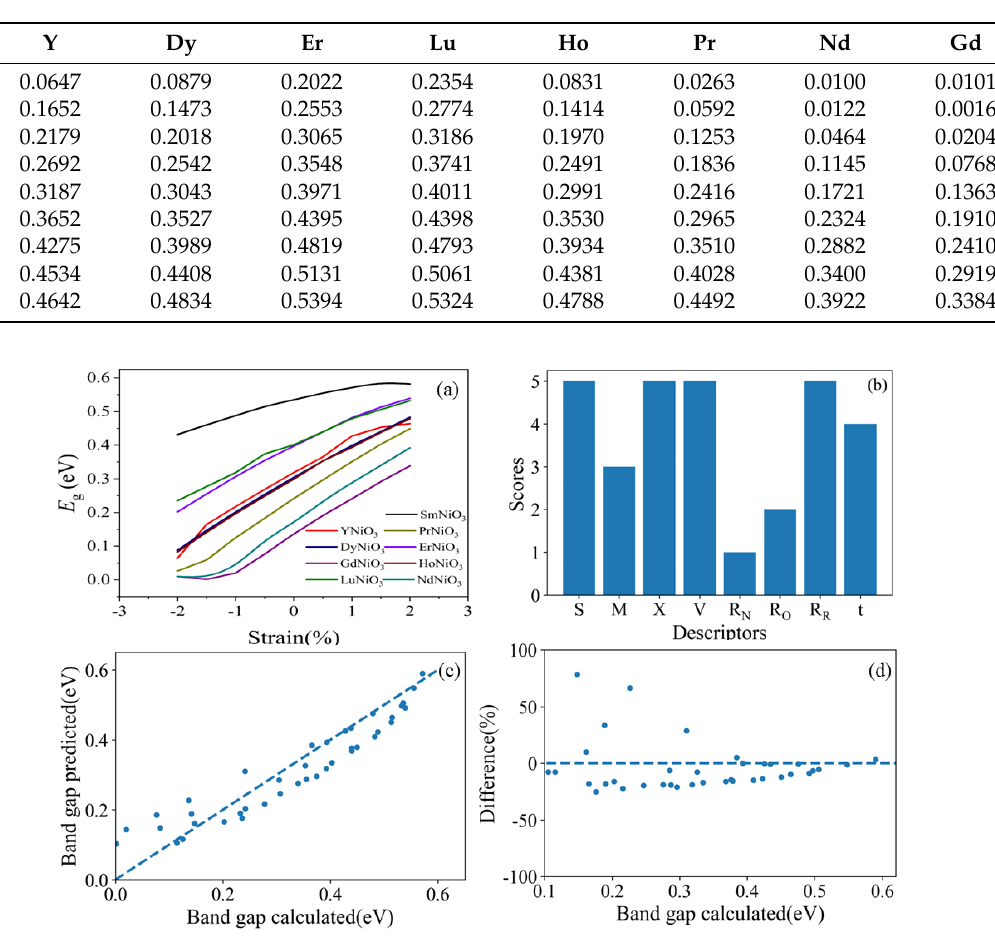
Figure 2. Band gaps of RE NiO 3 (R = Sm, Y, Pr, Ho, Dy, Er, Lu, Nd, and Gd) upon strains ranging from −2.0% to 2.0% ( a ). Scores of the planar strain of RE NiO 3 ( S ), relative atomic mass ( M ), electro- negativity ( X ), volume of supercells ( V ), nickel ion radius ( R N ), oxygen ion radius ( R O ), rare earth element ion radius ( R R ), and tolerance factor ( t ) given by RFE ( b ). Comparison between the band gap calculated by VASP and the band gap predicted by this model ( c ). Difference between the band gap calculated by VASP and the band gap predicted by this model ( d ). 3.2. Optical Properties Figure 3 displays the absorption spectrum of RE NiO 3 under different strains. In the far-infrared range (0.05 to 1.13 eV), there is an increase in absorption with the enhance- ment in photon energies. For RE NiO 3 under different strains, Figure 3 indicates that the compressive strain increases the light absorption, while the tensile strain suppresses it. Figure 4 displays the reflectivity of RE NiO 3 under different strains in the far-infrared range. There is a minimum reflectivity displayed around the photon energy of 0.3 eV. The tensile strain enhances the reflectivity in the range of 0.05–0.3 eV, whereas it decreases it when the photon energies are larger than 0.3 eV.